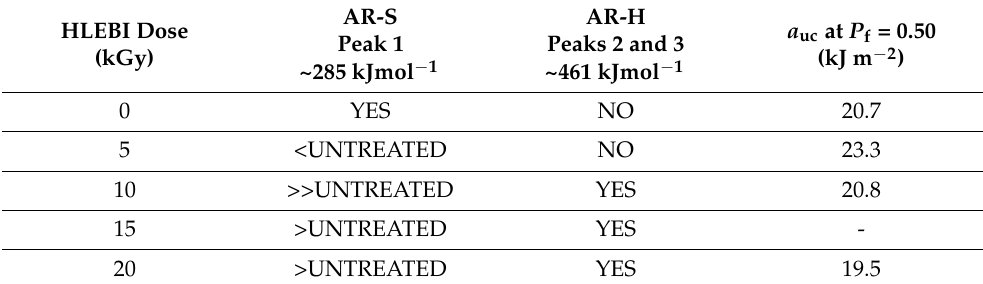
Figure 13. ESR signals of untreated samples (0 kGy) and those with the HLEBI dose (kGy) to PPS. Peaks 1, 2, and 3 corresponding to dangling bonds are indicated. Table 2. Summary of the effect of the HLEBI dose on ESR signal intensities in PPS and a uc at P f = 0.50 of the [PPS] 4 [CF] 3 composite. BDE values of AR-S and AR-H (kJmol − 1 ) from [21,22] are shown. HLEBI